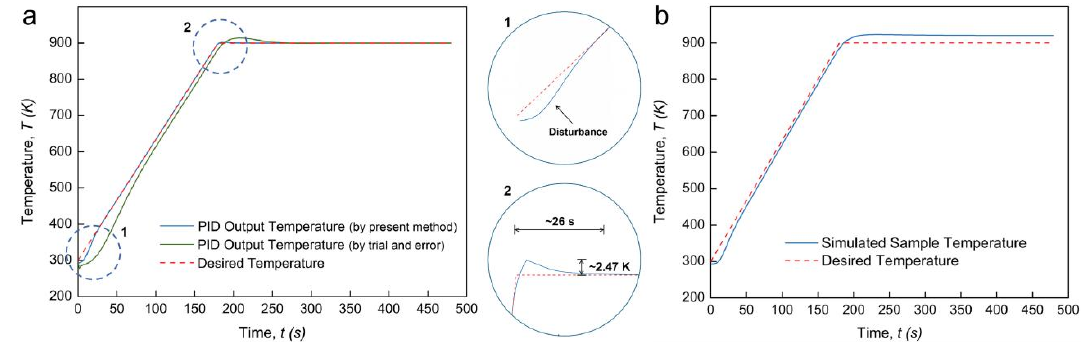
Figure 3. PID regulation outcome for regular temperature profile: ( a ) PID output temperature profile with enlarged views; ( b ) simulated sample temperature profile.